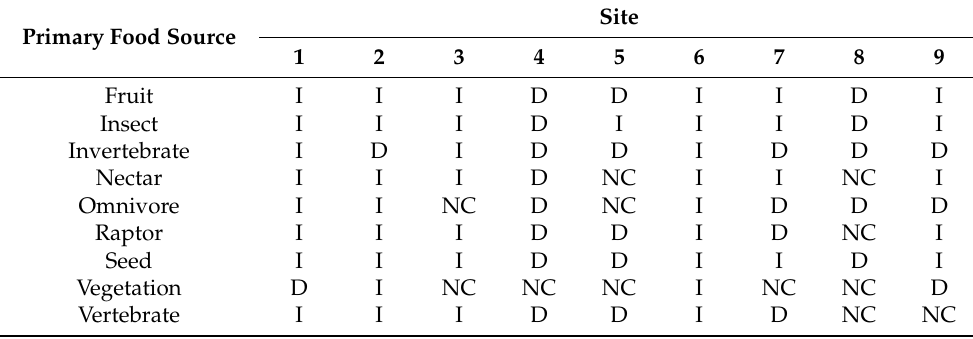
Table 3. Change in species numbers across sites where urbanisation has increased; I = increase, D = decrease and NC = no change.